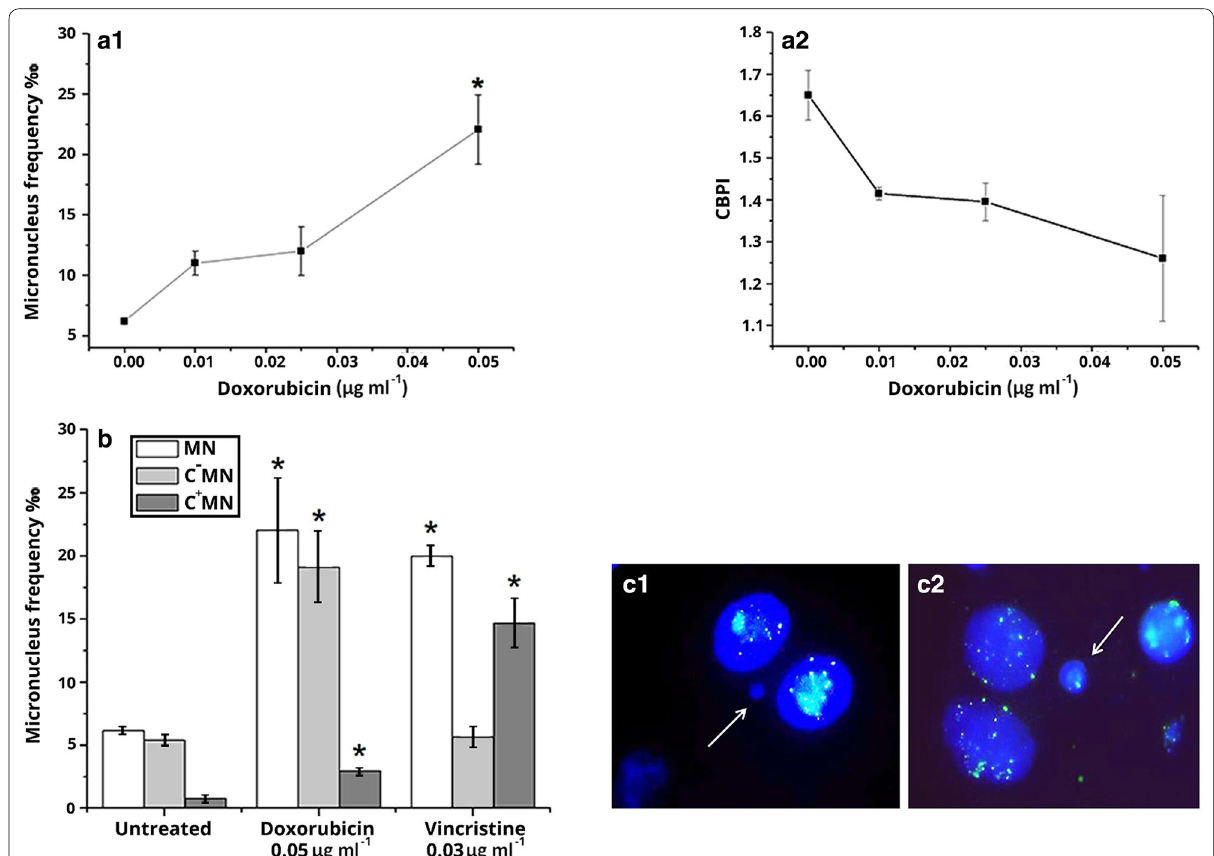
Fig. 4 a 1 Micronucleus frequency in human lymphocytes treated with doxorubicin. a 2 Cytokinesis Block Micronucleus Index (CBPI) in human lymphocytes treated with doxorubicin. b FISH analysis with pancentromeric probe. c Lymphocytes with C − MN ( c 1 ) and C + MN ( c 2 ). (C − MN: micronucleus without centromeric signal, C + MN: micronucleus exerting centromeric signal. * p Vincristine sulfate was used as a positive control. The values represent the average of the two donors. Bars represent standard